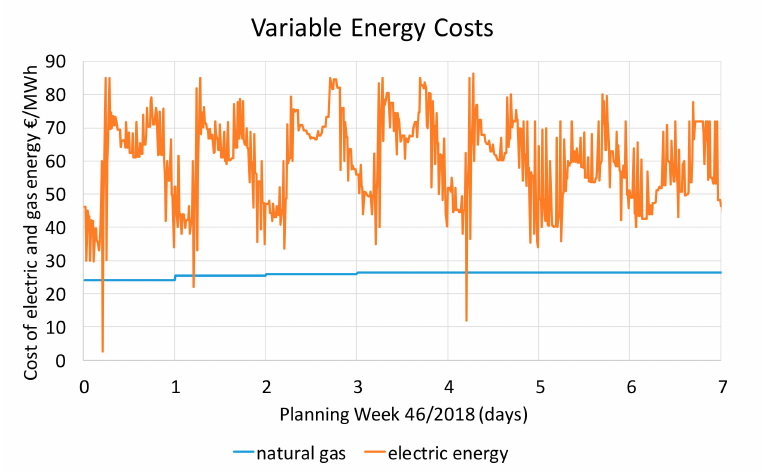
Figure 11. Dynamic energy costs (Week 46 /